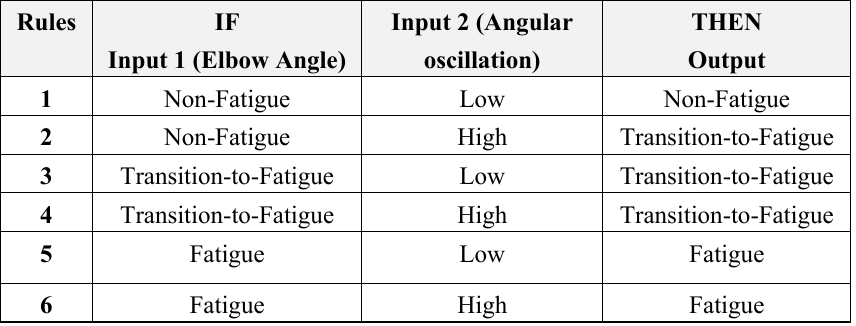
Table 1. Rule base for signal